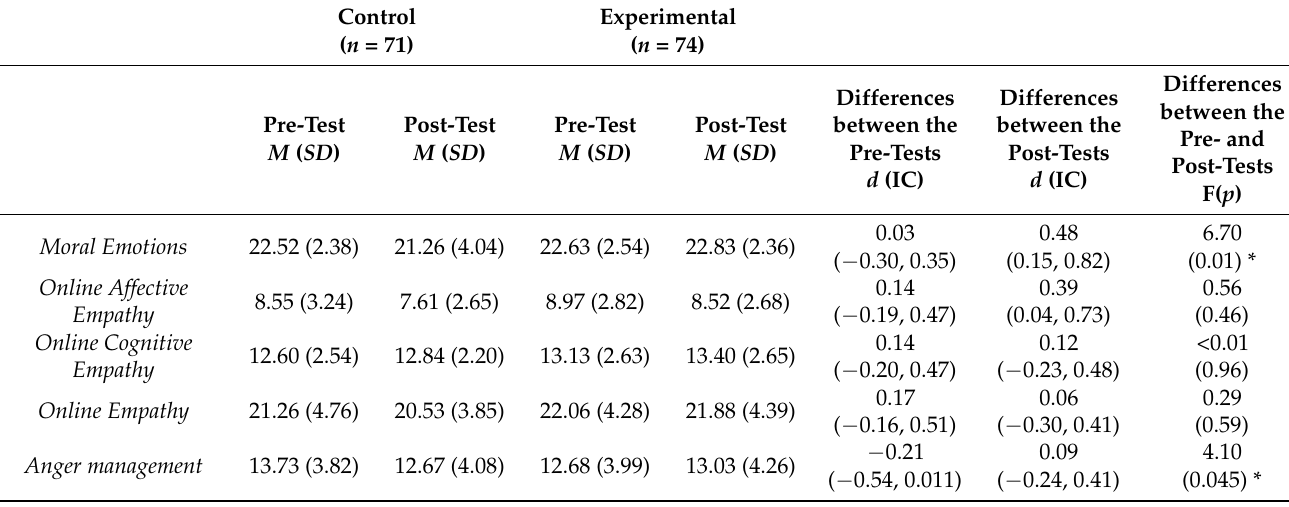
Table 5. Differences in pre-and post-test scores in moral emotions , anger management , and online empathy in the control and experimental groups.